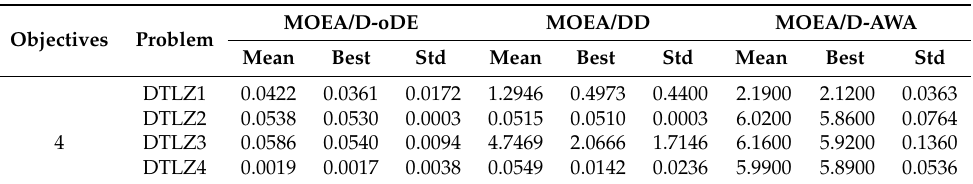
Table 6. Statistics of the IGD metric obtained by MOEA/D-oDE, MOEA/DD and MOEA/D-AWA on DTLZ1–DTLZ4 with 4 objectives.